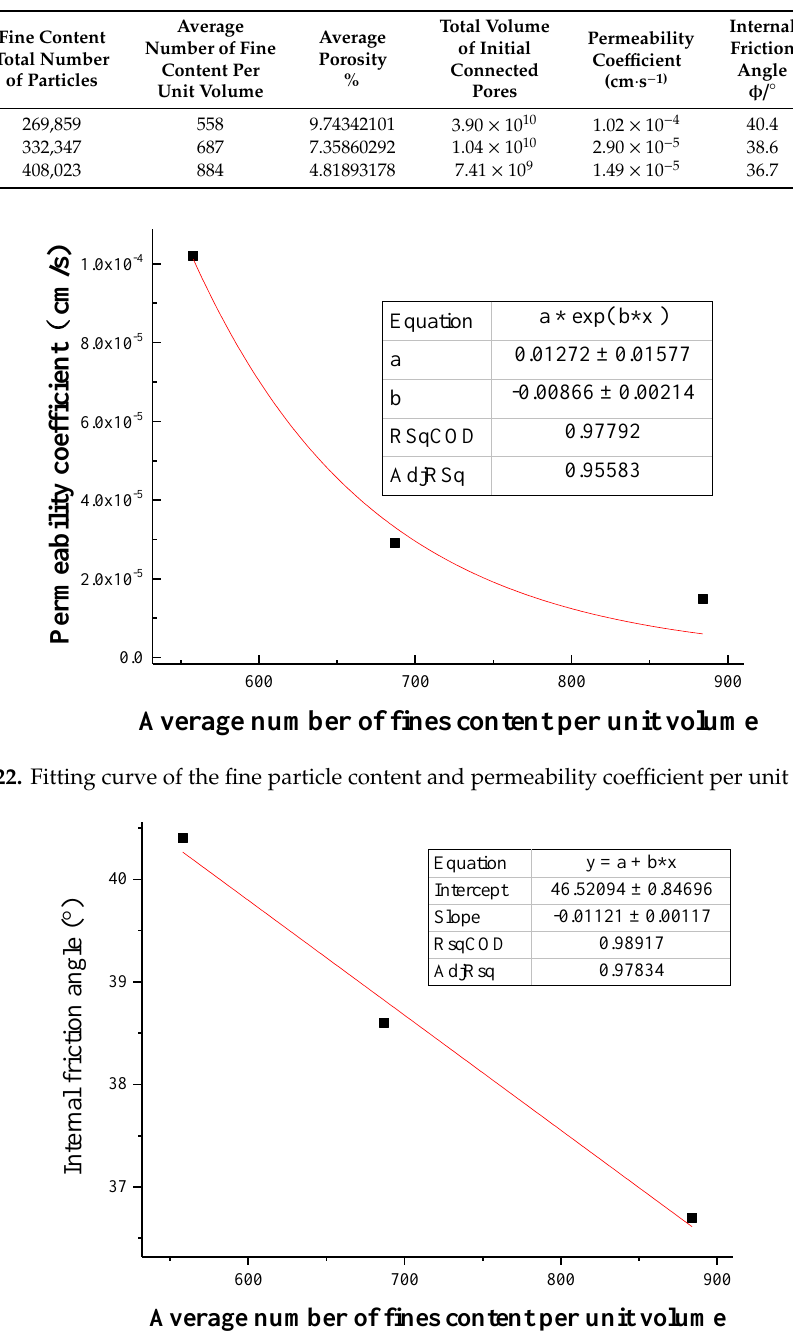
Figure 23. Fitting curve of the fine particle content and internal friction angle per unit volume.